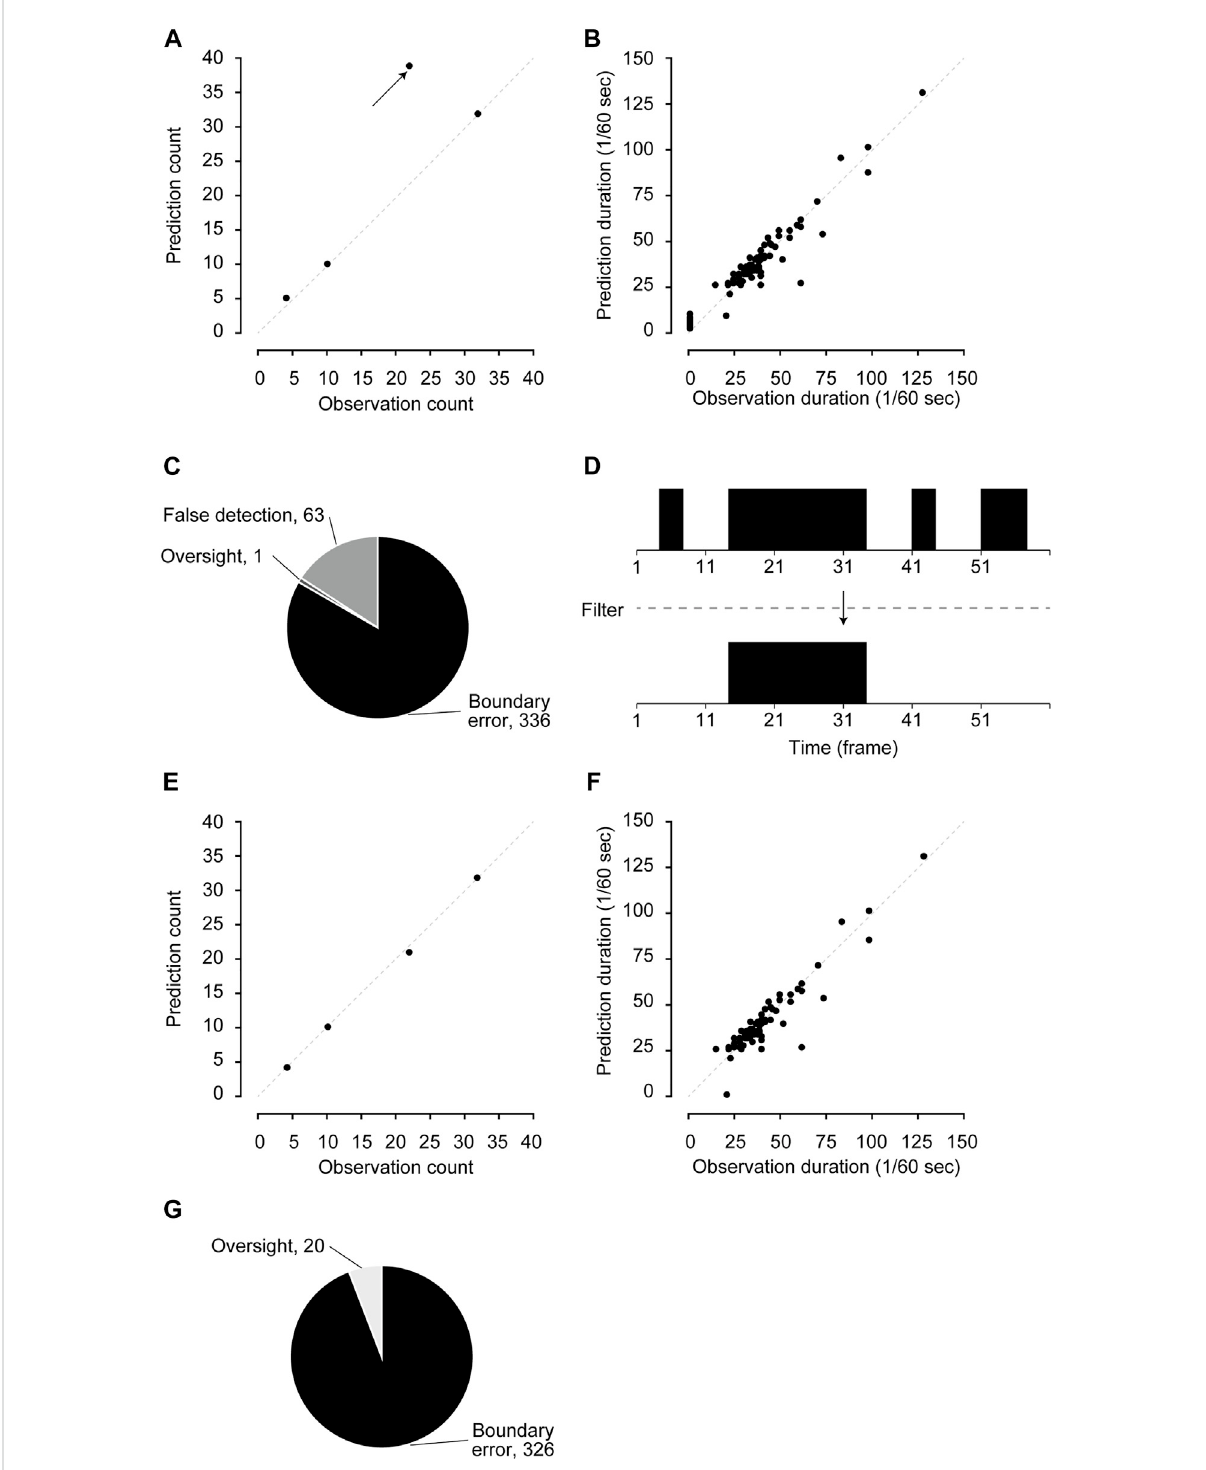
FIGURE 1 Performance validation and fi lter application. (A,B) The comparison of the number of scratching bouts (A) and duration (B) between human observation and pre- fi ltered predictions. (C) Details of mis-predicted frames in pre- fi ltered predictions. (D) Schematic fi gure of the posterior fi lter. (E,F) The comparison of the number of scratching bouts (E) and duration (F) between human observation and post- fi ltered predictions. (G) Details of mis- predicted frames in post- fi ltered